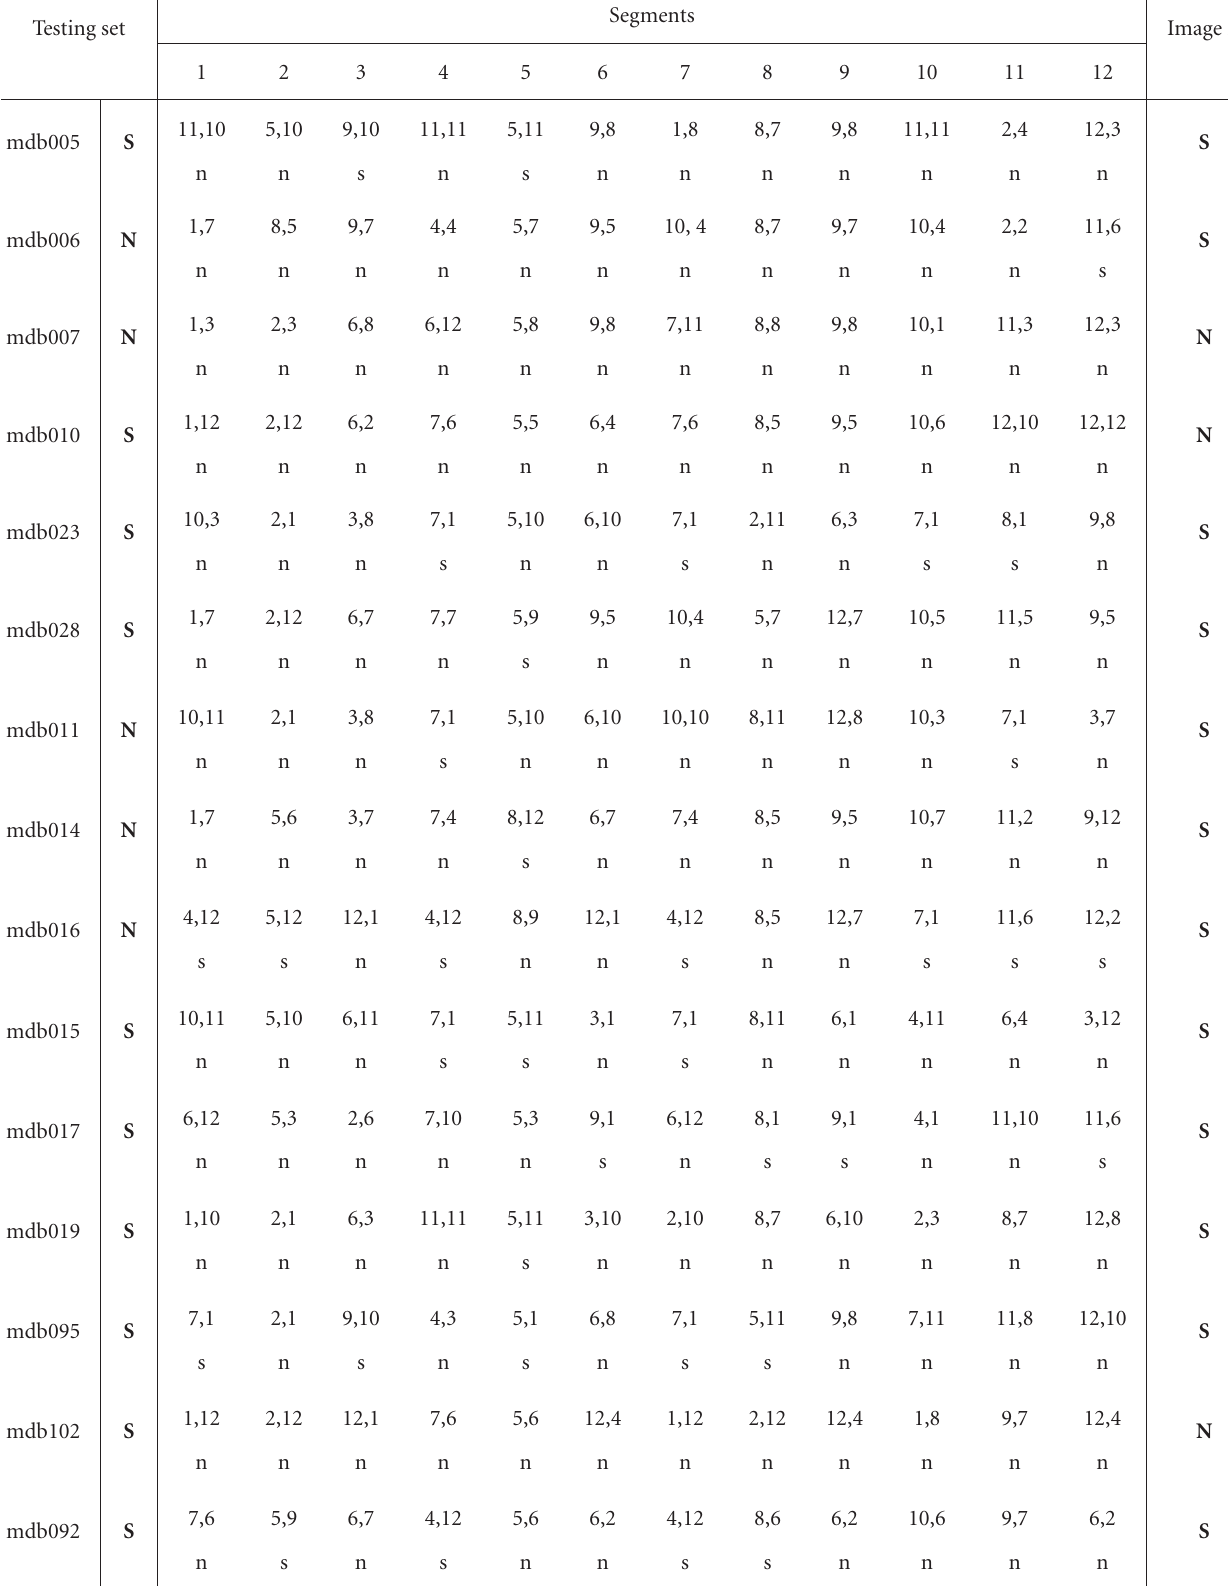
Table 3: Results using block processing with Chebyshev distance. Note: first number indicates the block number and second one signifies the image number in training